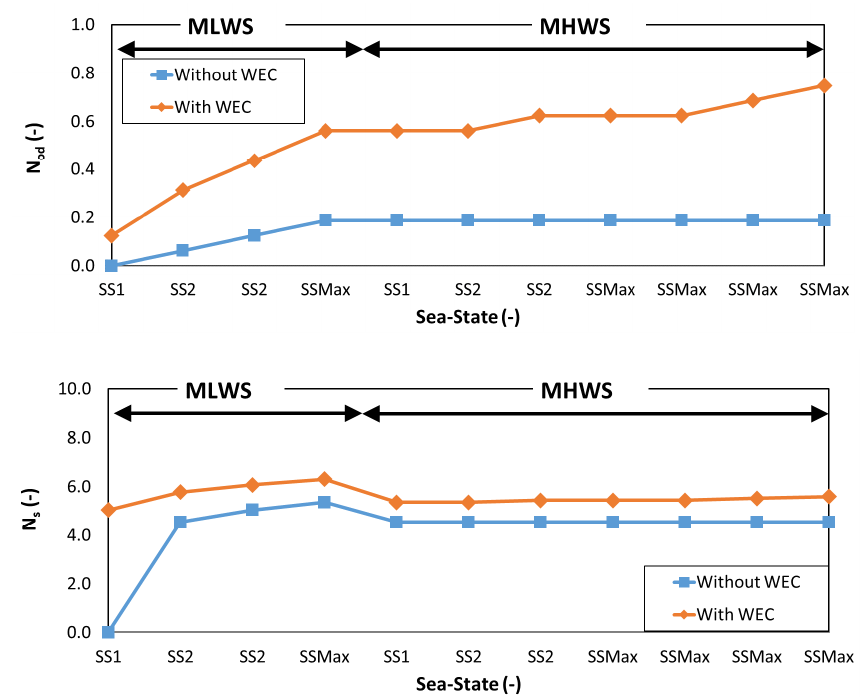
Figure 11. N od and N S values for the extreme sea-state tests, with and without the WEC, for the toe Figure 11. (cid:1840) (cid:3042)(cid:3031) and (cid:1840) (cid:3020) values for the extreme sea-state tests, with and without the WEC, for the toe berm berm blocks.